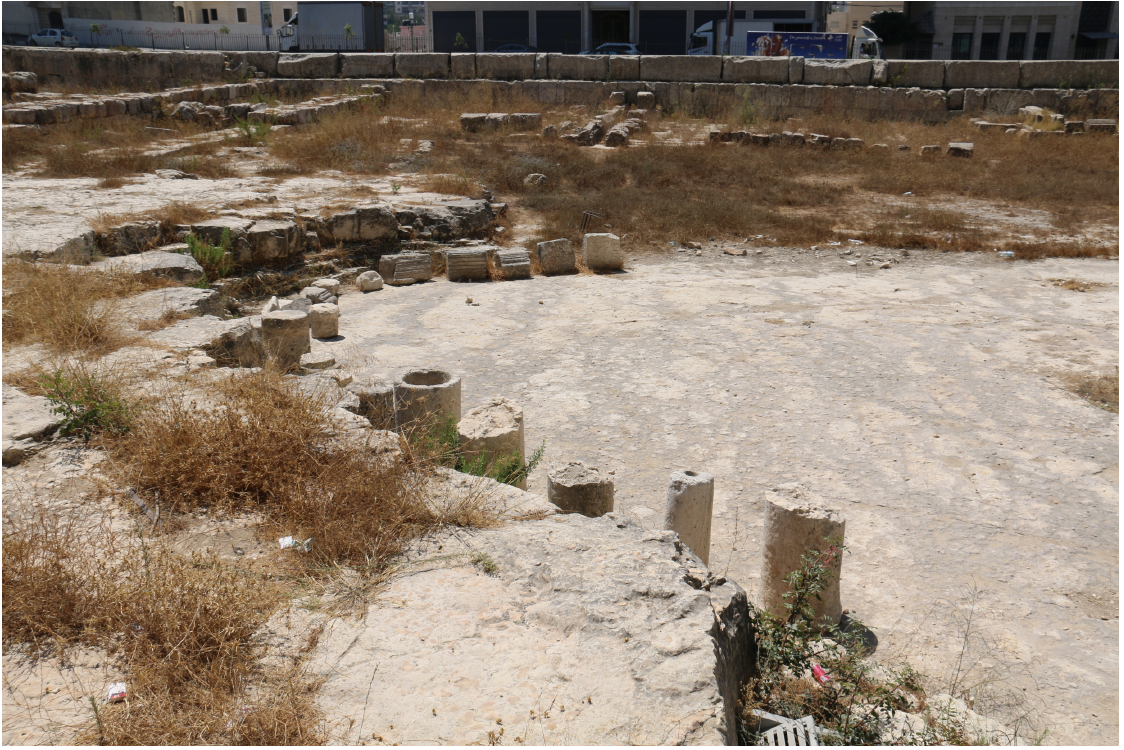
Figure 4 Remains of late antique columns and architectural ornaments, small altars, and vessels for libation sacrifices (and some modern rubbish), as now presented in the formerly open area of the sanctuary (photo: Katharina Heyden,